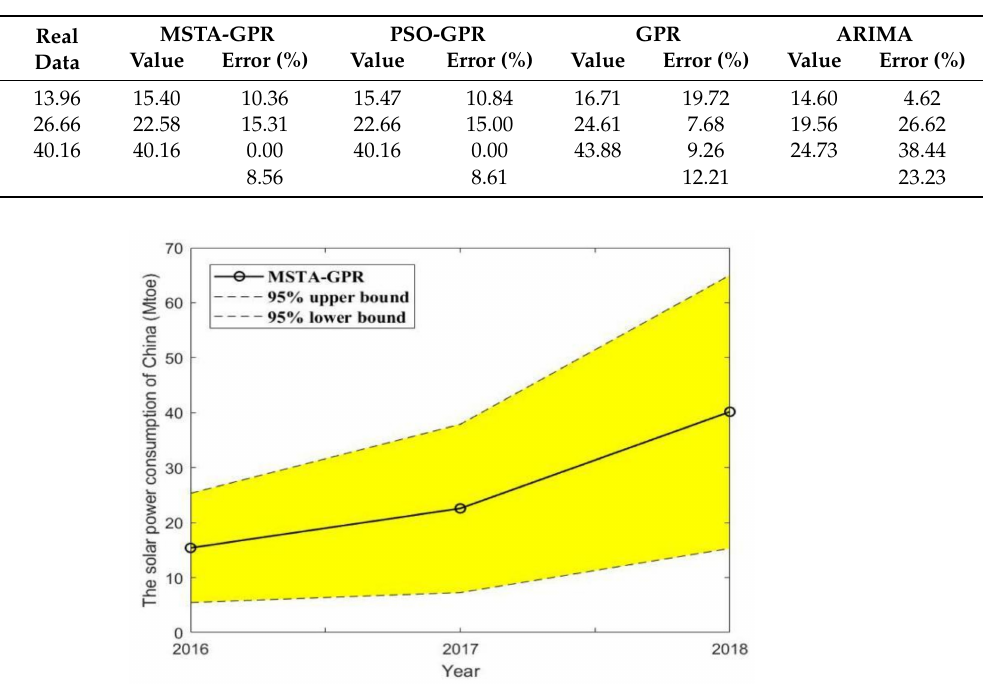
Figure A2. The interval prediction result of MSTA-GPR for China’s wind power consumption. Table A3. Solar power consumption data for China from 2016 to 2018 (Mtoe).